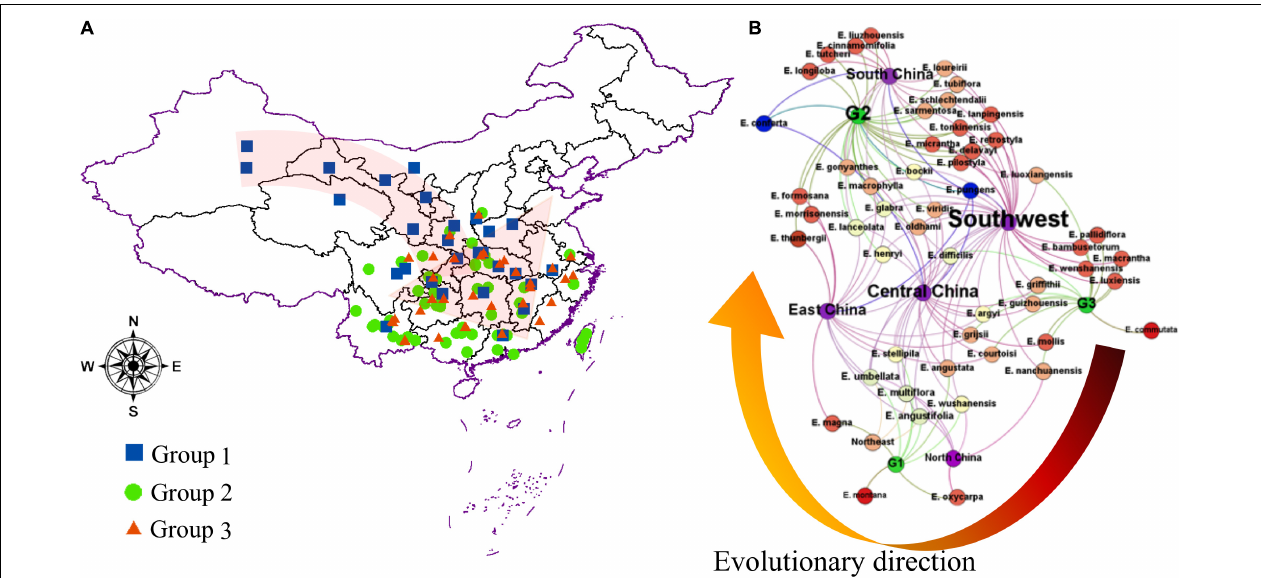
FIGURE 4 | The geographical dispersion of the genus Elaeagnus in China. (A) Distribution of the main Chinese genus Elaeagnus , and three groups were divided by using the OPLS-DA model; (B) Neural Network analysis for distribution of different groups of genus Elaeagnus in